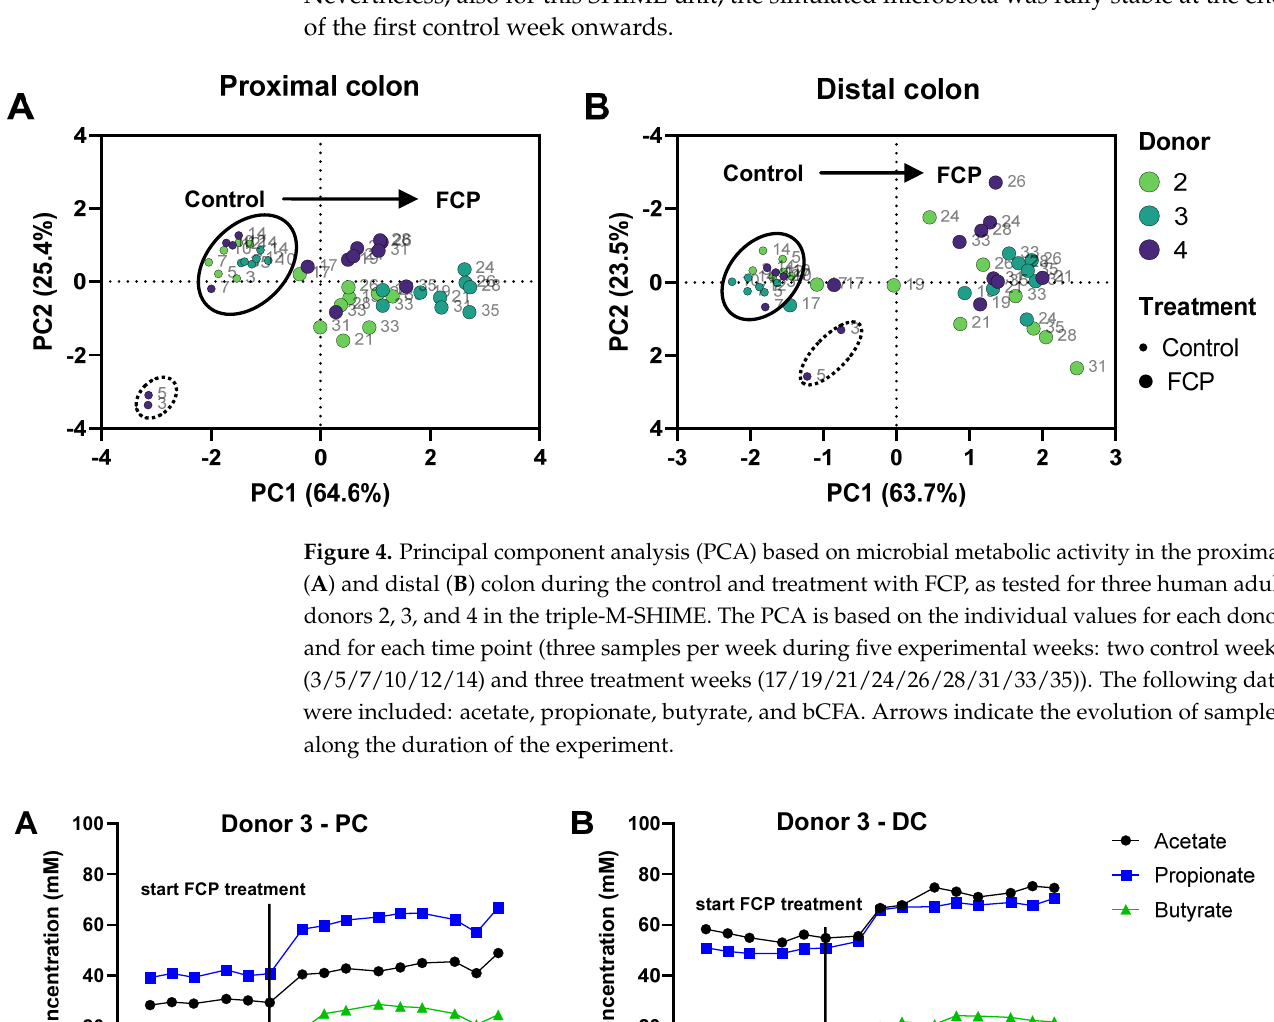
Figure 6. Effect of fermentation of FCP on microbial activity in the simulated proximal and distal colon of the triple-M-SHIME during both the final week of the control (Days 9–14) and treatment period (Days 30–35). The data is presented as the average value (± SEM) of acetate ( A ), propionate ( B ), butyrate ( C ) and bCFA ( D ), across the three samples collected per week for each of the three human adult donors tested ( n = 9). Statistically significant differences between samples collected during the final control and treatment week are indicated by */*** (0.01 < adjusted p- value < 0.05/ p < 0.001). 3.3. Repeated Adminsitration of FCP Consistently Altered Microbial Composition in the Simulated Proximal and Distal Colon with Some Interpersonal Differences across the Three Human Adults Tested in the Triple-M-SHIME (Test 2) When microbial diversity in the lumen was evaluated, it remained unaffected. In con- trast, FCP treatment significantly increased bacterial diversity from 10.1 ± 1.8 up to 22.9 ± 3.1 in the mucosal environment of the distal colon (adjusted p -value = 0.017) (Figure 7).